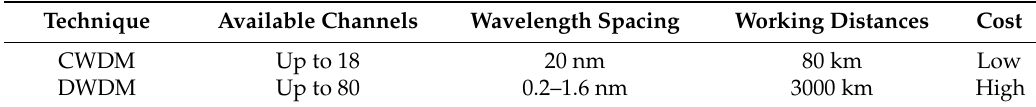
Table 5. Techniques for wavelength division